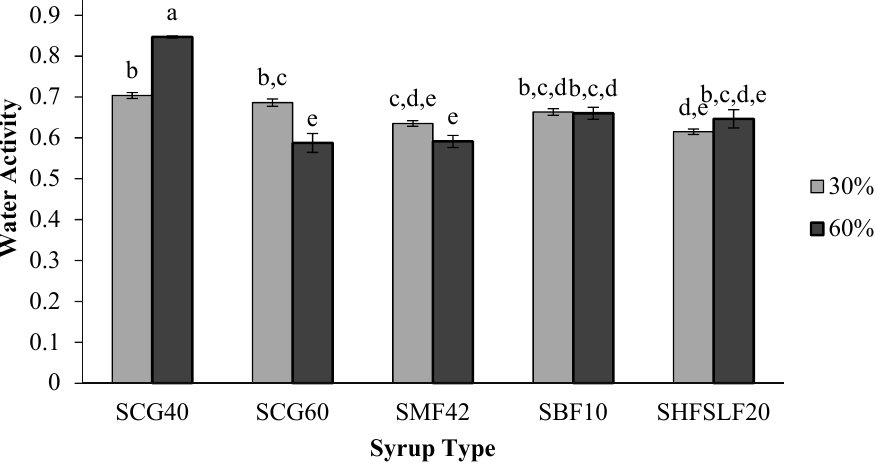
Figure 2. Effect of corn syrup type and concentration on the a w of the formulated candies. Small letters indicate the significant differences ( p < 0.05) between the samples. Each bar represents a different sample. Errors are represented as standard